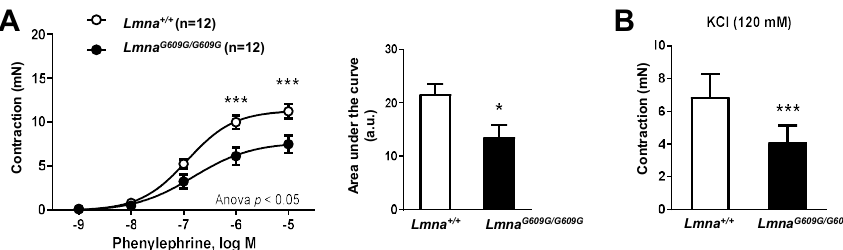
Figure 1. Defective aortic contraction in Lmna G609G / G609G mice. Thoracic aortas from 14-week-old progeroid Lmna G609G / G609G mice (ubiquitous progerin expression) and wild-type ( Lmna +/+ ) mice were analyzed by wire myography (n = 12 for each genotype). ( A ) Strength of contraction induced by phenylephrine (left) and representation of the area under de curve (right; a.u.: arbitrary units). ( B ) Strength of contraction induced by KCl. Statistical differences were analyzed by two-way ANOVA with Bonferroni’s post-hoc test for phenylephrine data, and by two-tailed t-test for KCl data. * p < 0.05 *** p < 0.001.